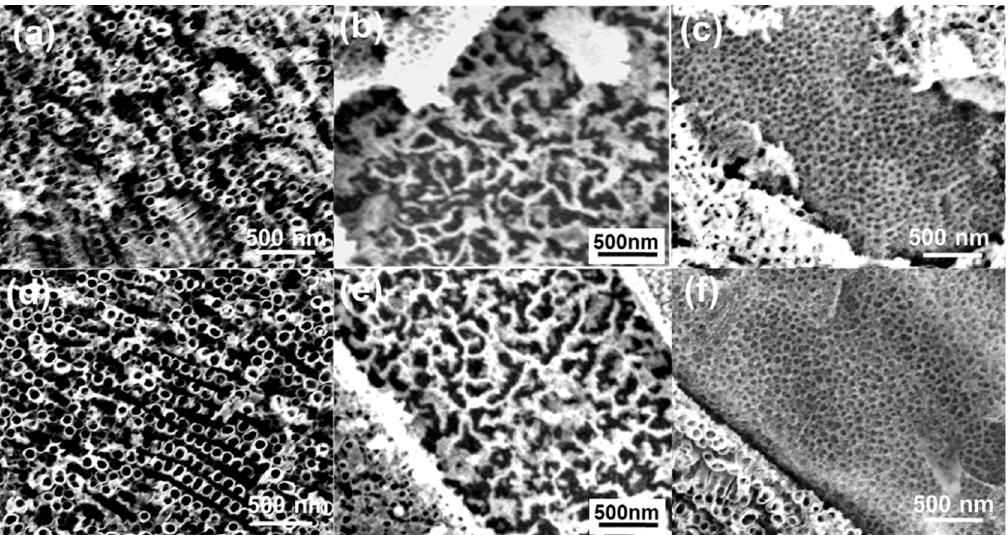
Figure 5. Top-view SEM images of the Ti-Ni-Si-O nanostructures grown in the α -Ti phase, Ti 2 Ni phase and Ti 5 Si 3 phase at 40 V for different times. ( a – c ) 60 min, and ( b – f ) 120 min. All anodization experiments were carried out in EL-4 electrolyte.